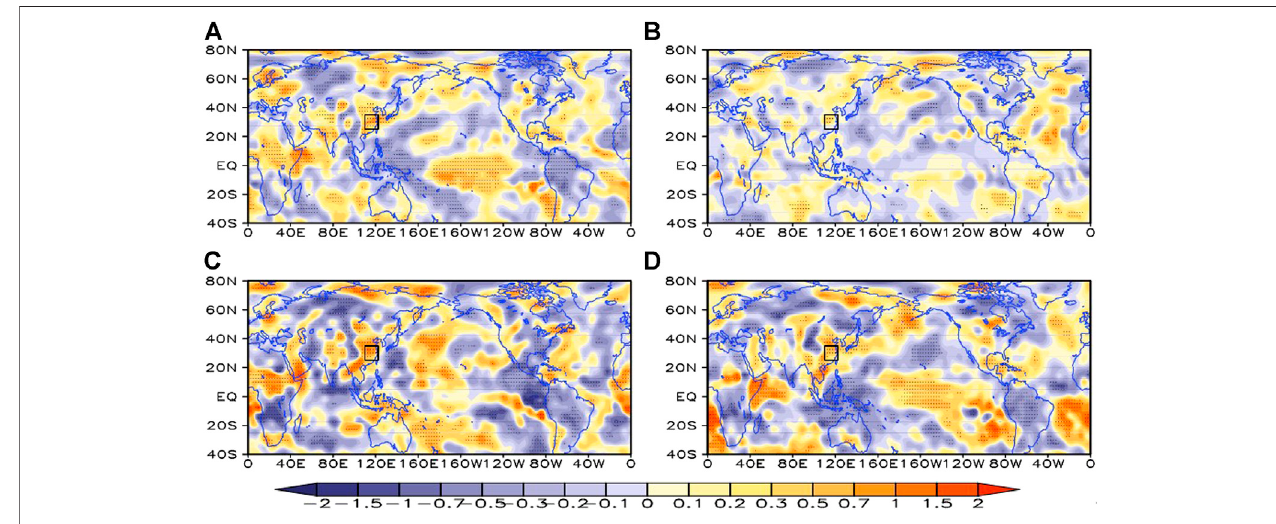
FIGURE 7 | Regression coef fi cient fi eld ofthe PRR intheMLRYR and the 500 hPavertical velocity in (A) spring, (B) summer, (C) autumn and (D) winter[units:/(Pa/s)]. The dotted area indicates that it passed the 95% signi fi cance test and the black rectangular box represents the MLRYR.